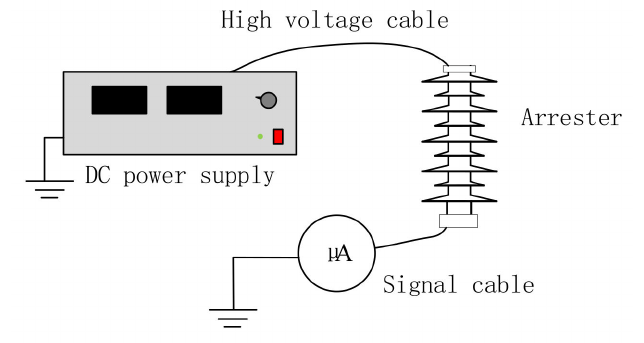
Figure 2. DC Voltage test circuit.